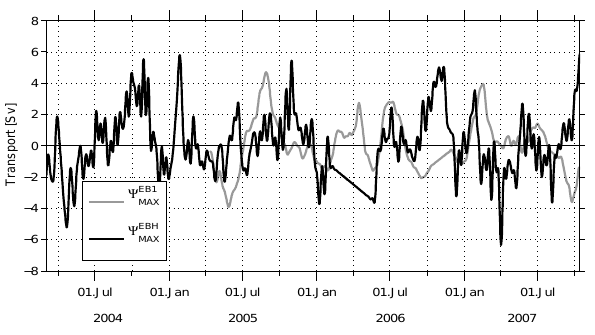
Fig. 12. 10-day low-pass filtered anomalies of the eastern-boundary contribution to the AMOC at 26.5 ◦ N as derived form EB1 ( 9 EB1 gray) and EBH ( 9 EBH , black). Linear interpolation is chosen to MAX fill the time gaps. Positive transports correspond to northward flow.